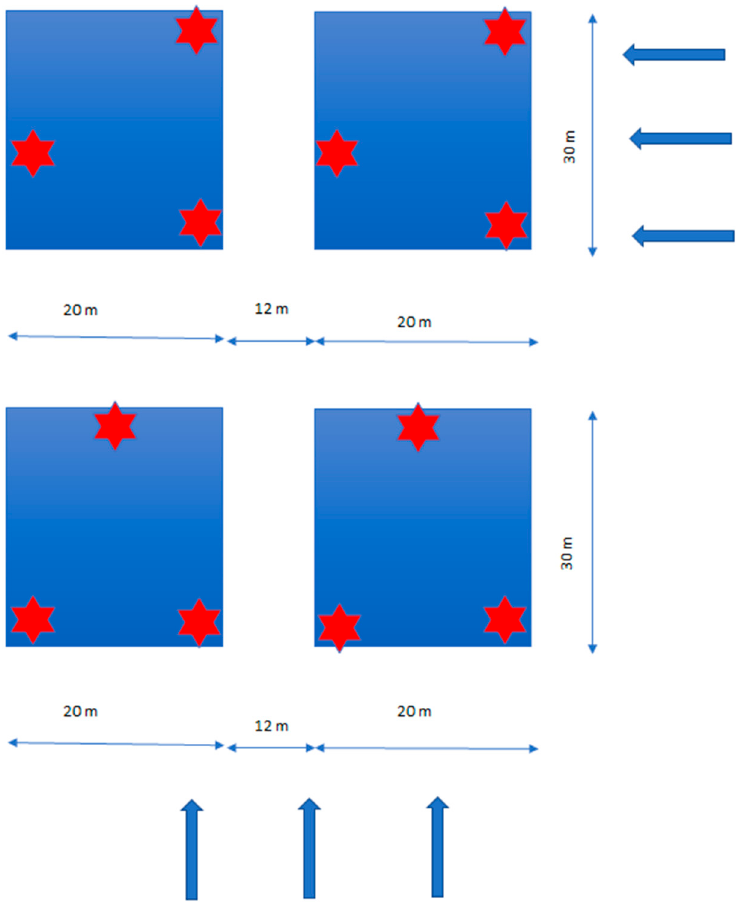
Figure 17. Proposed staggered arrangement of wind turbines on the typical building roof by au- thors.